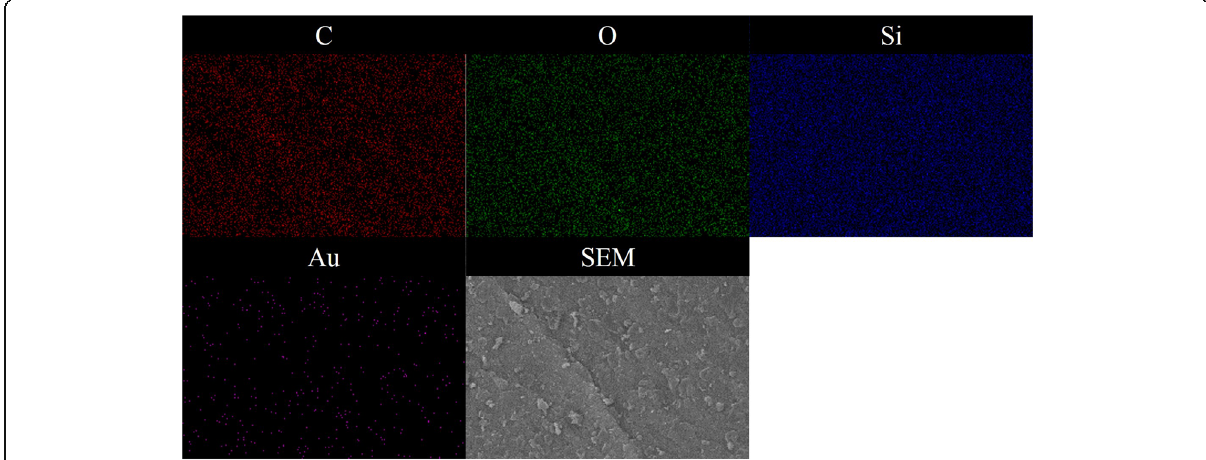
Fig. 6 SEM-EDX mapping results of cellulose-amino POSS hybrid composite by PVA/THPC process